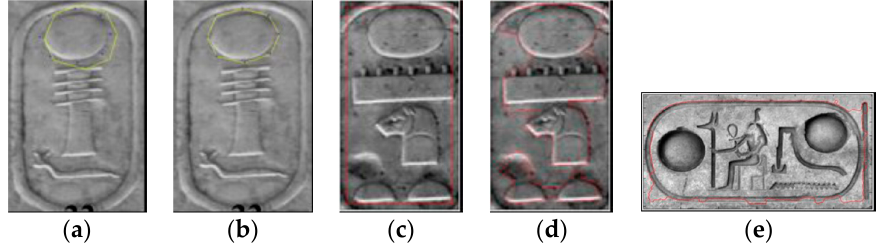
Figure 2. ( a , b ) AAM method applied to hieroglyph images; Active Contour Algorithm applied to obtain the edge of the Egyptian hieroglyphs ( c ) initially; ( d ) after 1000 iterations; ( e ) Active Contour Algorithm applied to obtain the edge of the Egyptian cartouche after 300 iterations.